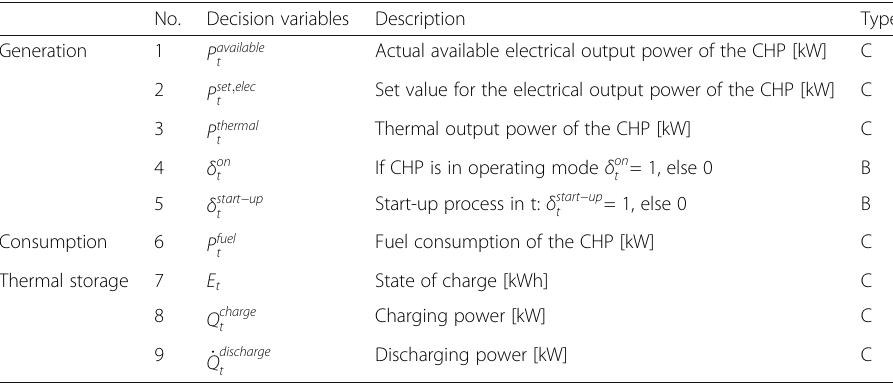
Table 1 Decision variables. Index t: Current time